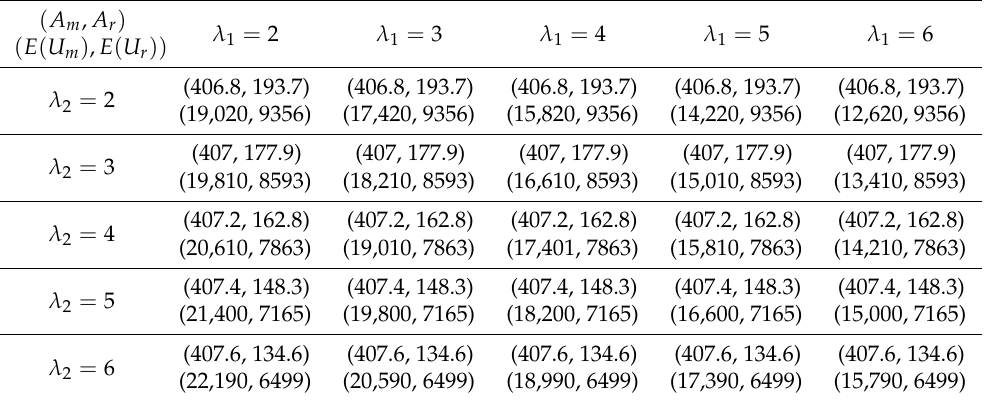
Table 2. Nash equilibrium points ( A m , A r ) and expected utilities ( E ( U m ) , E ( U r )) with respect to λ 1 and λ 2 with α 1 = 3.5 and α 2 = 3.5.